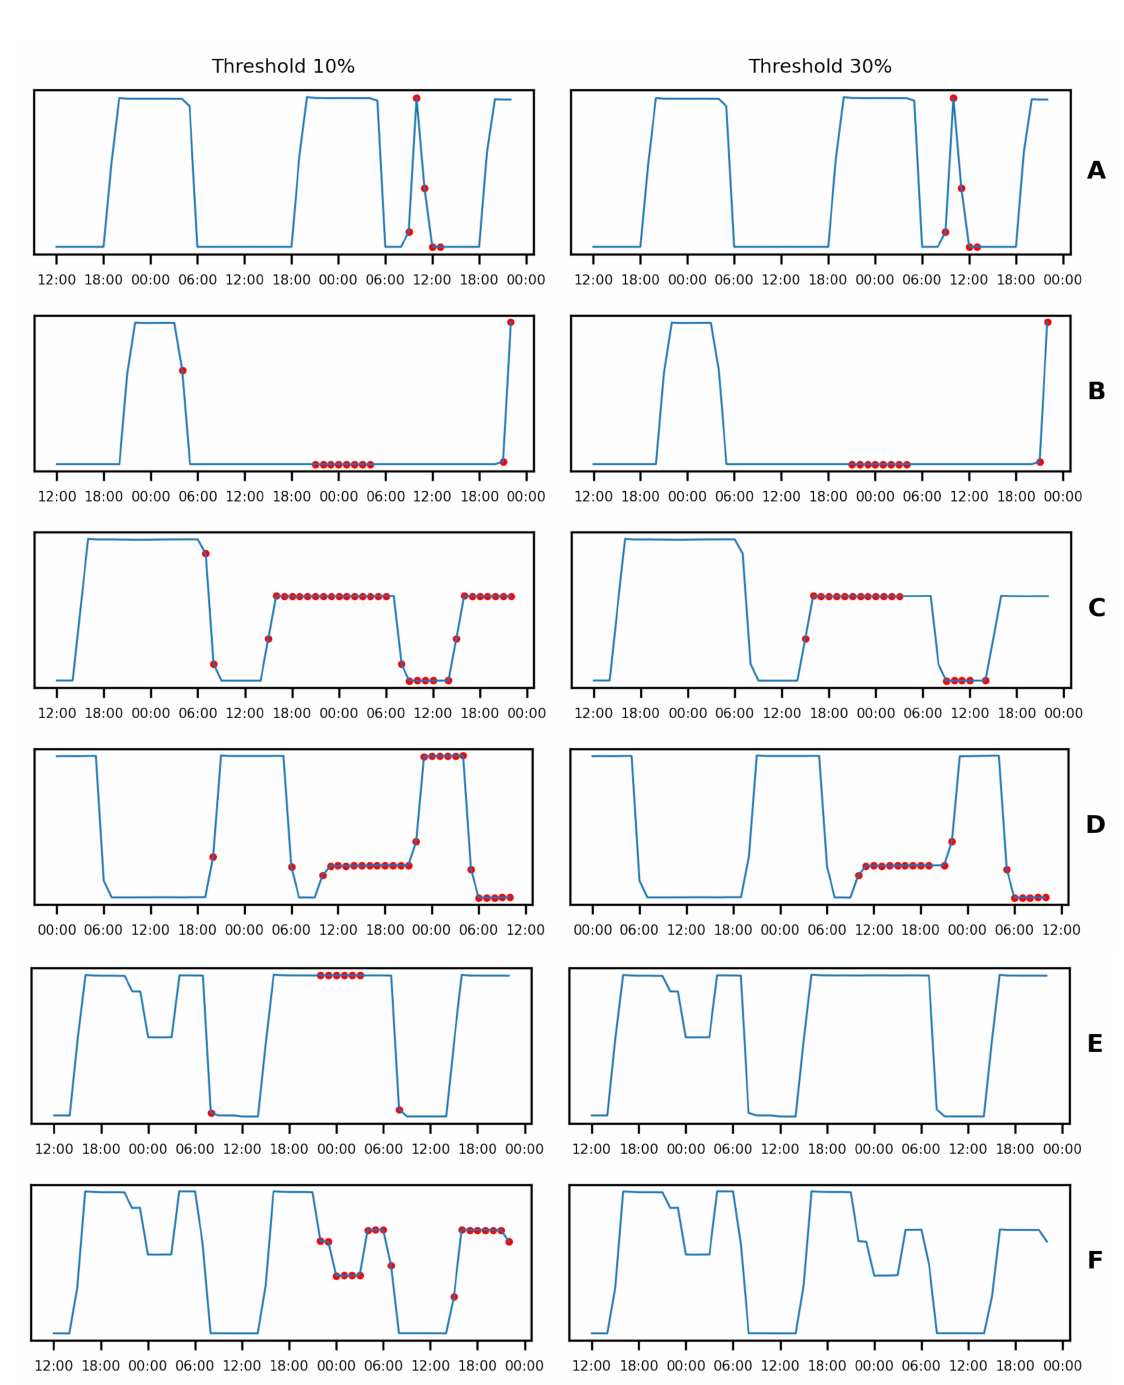
Figure 13. Application of different thresholds for anomaly detection for the SARIMA algorithm. Subfigures ( A – F ) correspond to anomalies discussed in Section 3. Red circles indicate measurements for which the threshold has been exceeded (in 10% or